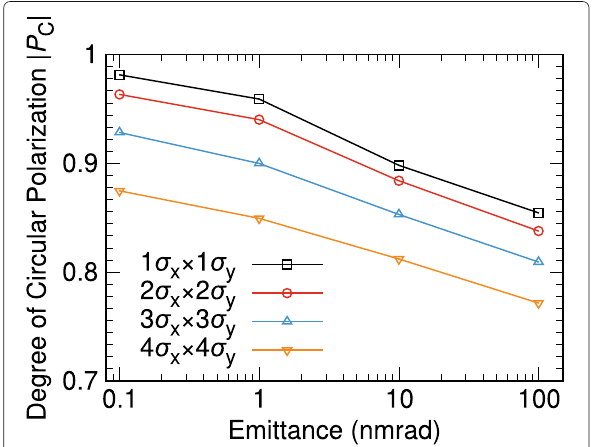
Fig. 31 The dependence of | P C | of the side peak on the emittance and